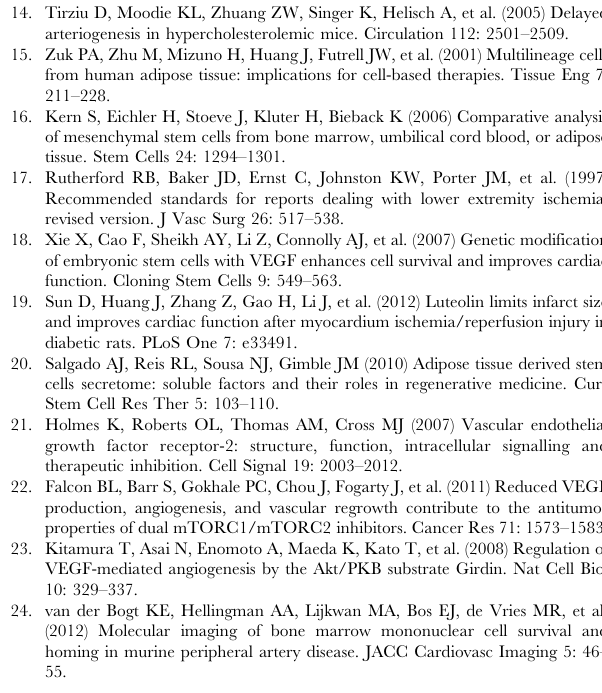
Figure S2 Representative BLI of transplanted cells in the left ischemic hindlimb (a). In vivo BLI demonstrated that peak